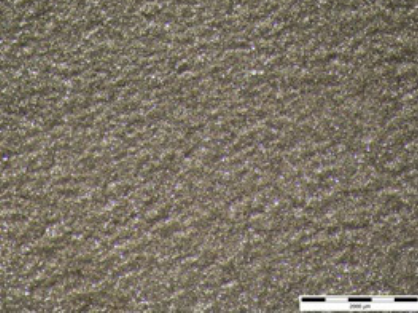
Figure 7: Macro views on evaluated